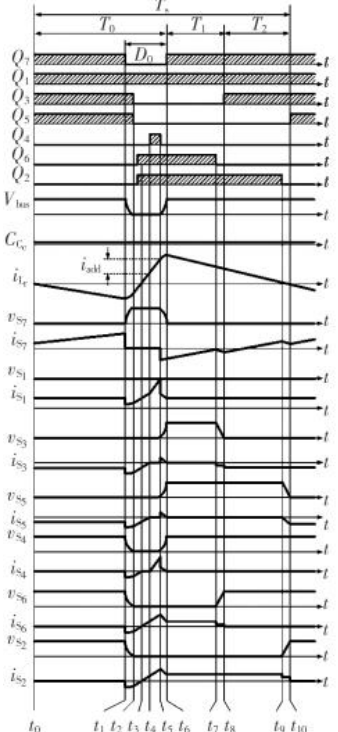
Fig. 2. Key waveforms in the stage of analysis